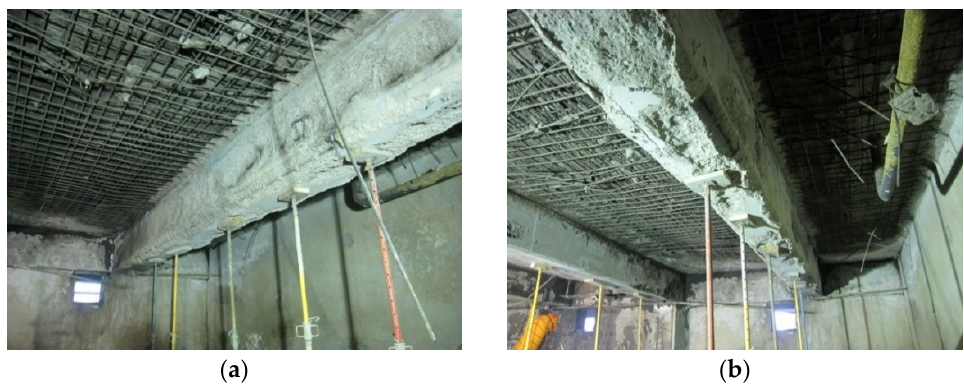
Figure 8. Damage to Beam #2. ( a ) East side of beam seen from the north. ( b ) West side of beam seen from the north.